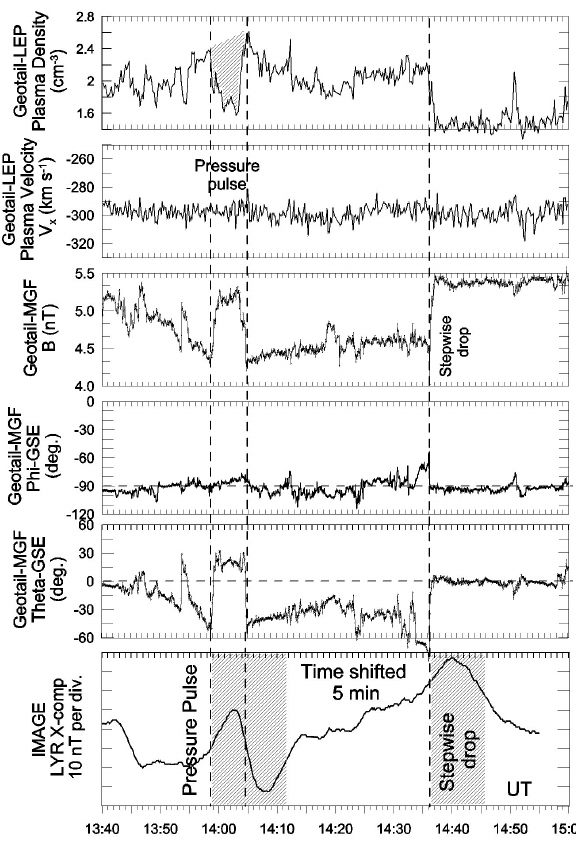
Fig. 8. Negative solar wind pressure pulse (top panel, shaded area) and stepwise pressure drop (single vertical dashed line) occurred on 2 July 1997. Measurements of plasma density and velocity as well as vector magnetic field from the Geotail plasma (LEP) and mag- netic field (MGF) experiments are shown. The level of solar wind plasma velocity (second panel) is not affected by pressure varia- tions. The ground LYR station X-component trace (from the IM- AGE array) shows the characteristic signatures (shaded areas) cor- responding to the pressure pulse and pressure drop.